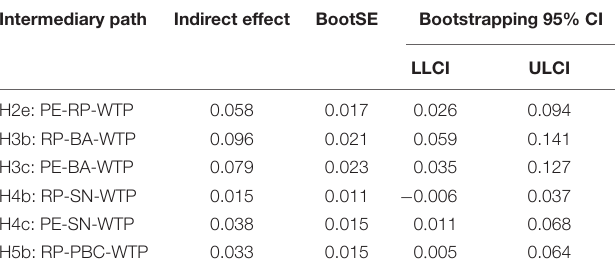
TABLE 7 | Bootstrap analysis results of the mediation effect